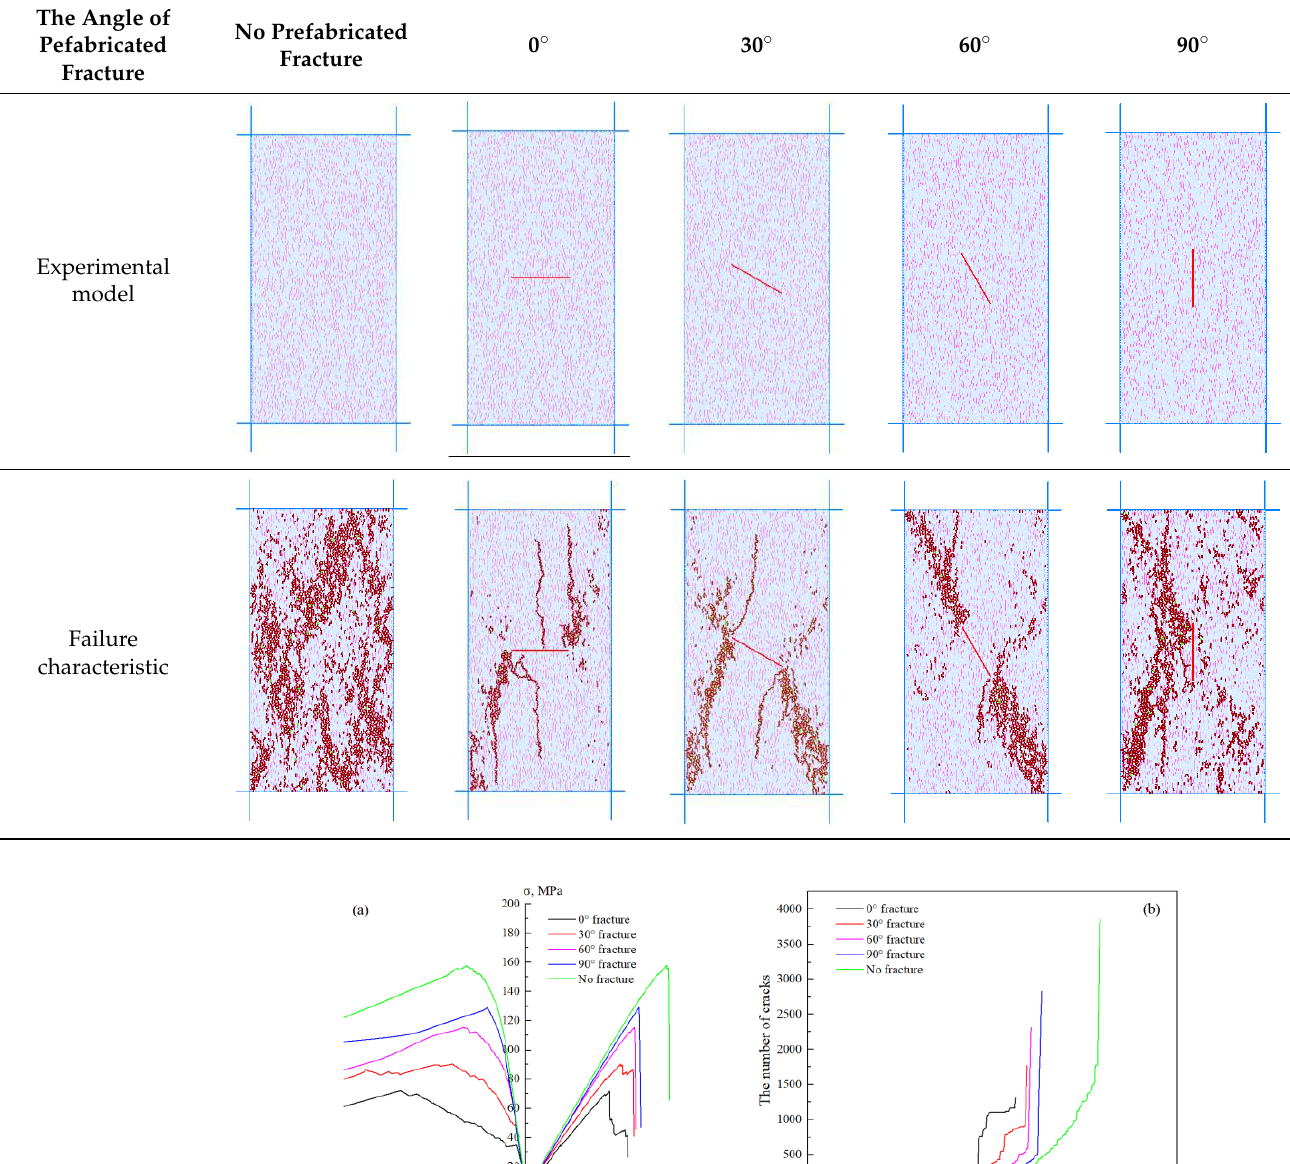
Table 1. The failure characteristics of granite by triaxial compression simulation.